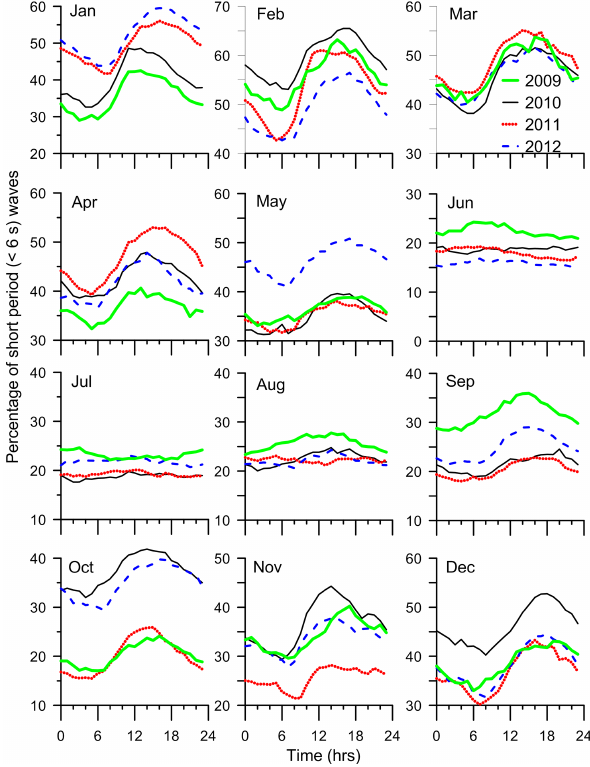
Figure 11. Variation in half-hourly significant wave height averaged monthly with time.